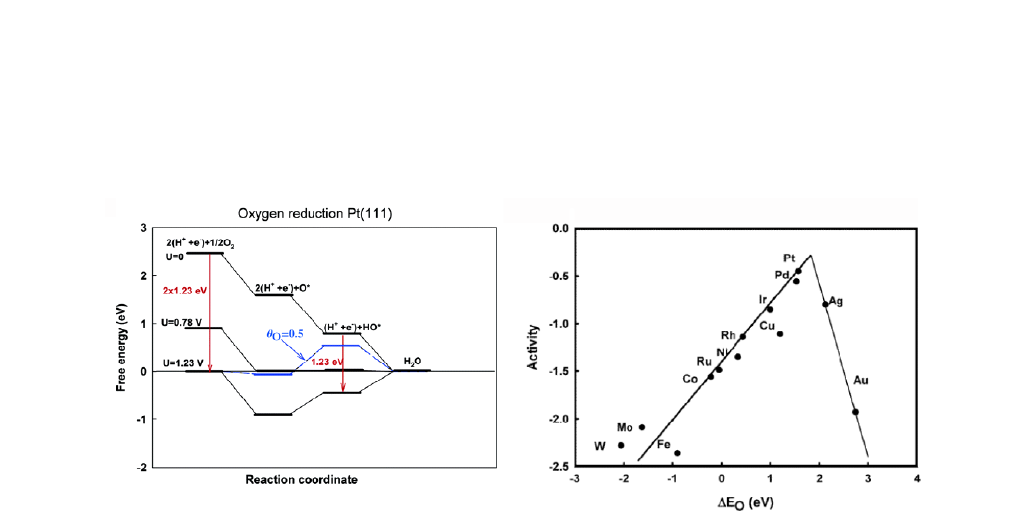
Fig. 15. – Nørskov an coworkers discuss the origin of the overpotential for the ORR in detail. Left: computed reaction path depending on the applied potential. Right: volcano plot for the ORR, for which the oxygen adsorption strength is plotted agains the activity of a catlyst material. Figure reproduced with permission from